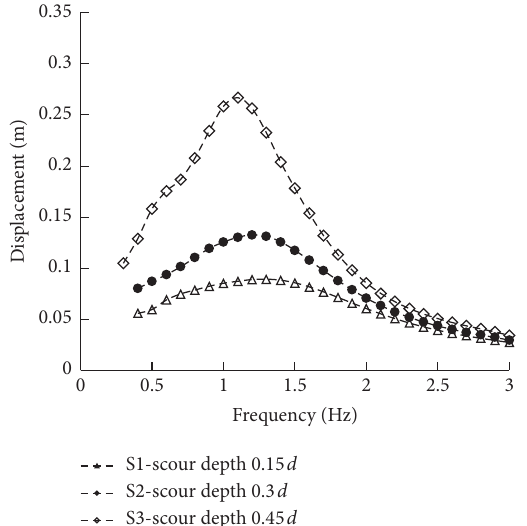
Figure 13: Dynamic response of caisson foundation under dif- ferent scour depths.